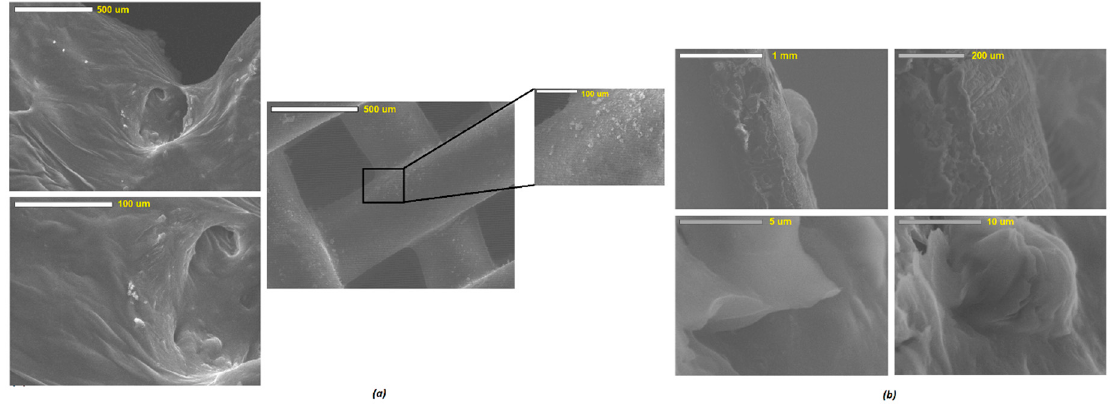
Figure 4. SEM images of ( a ) bioprinted, and ( b ) cross-section of PLA/PEG/EPO-based scaffolds.